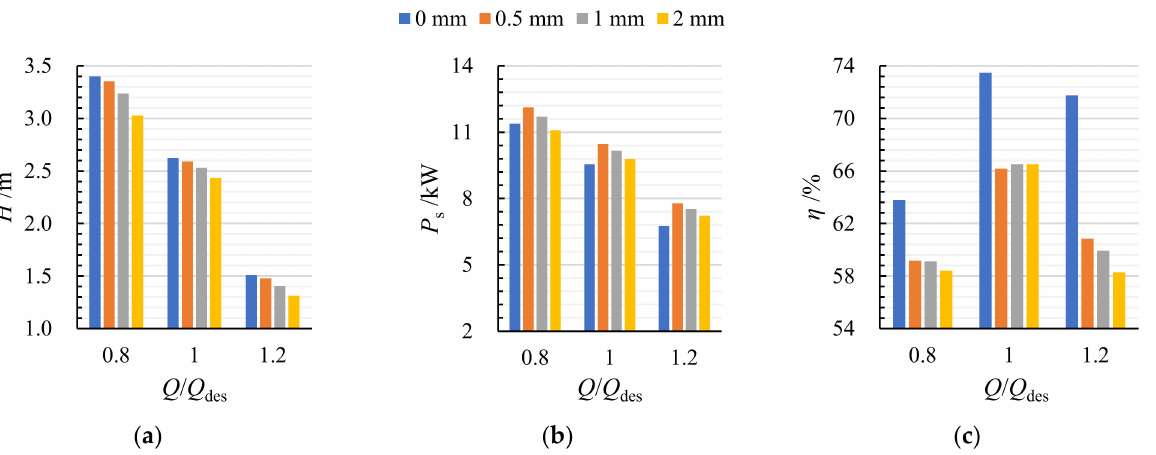
Figure 6. Comparison of calculated ( a ) head, ( b ) shaft power and ( c ) efficiency under different R